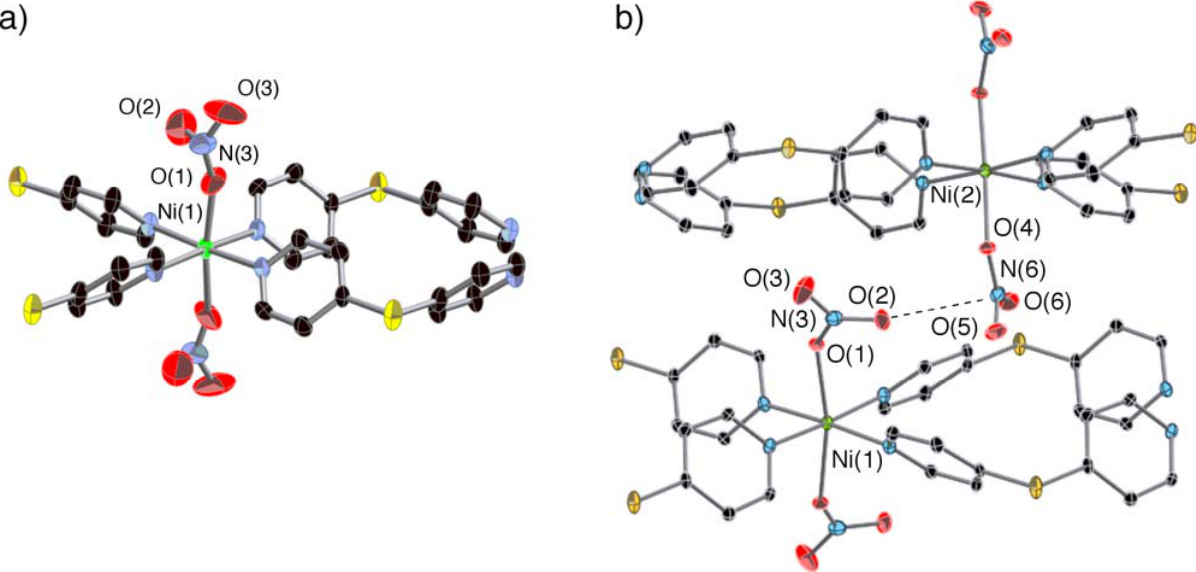
Figure 1. Coordination circumstances of 1  ( a ) and 1  ( b ). Hydrogen atoms are omitted for clarity. 1  contains two crystallographically independent ( Ni - dps anions in the different chains are connected by electrostatic interactions as shown by dashed line ( b